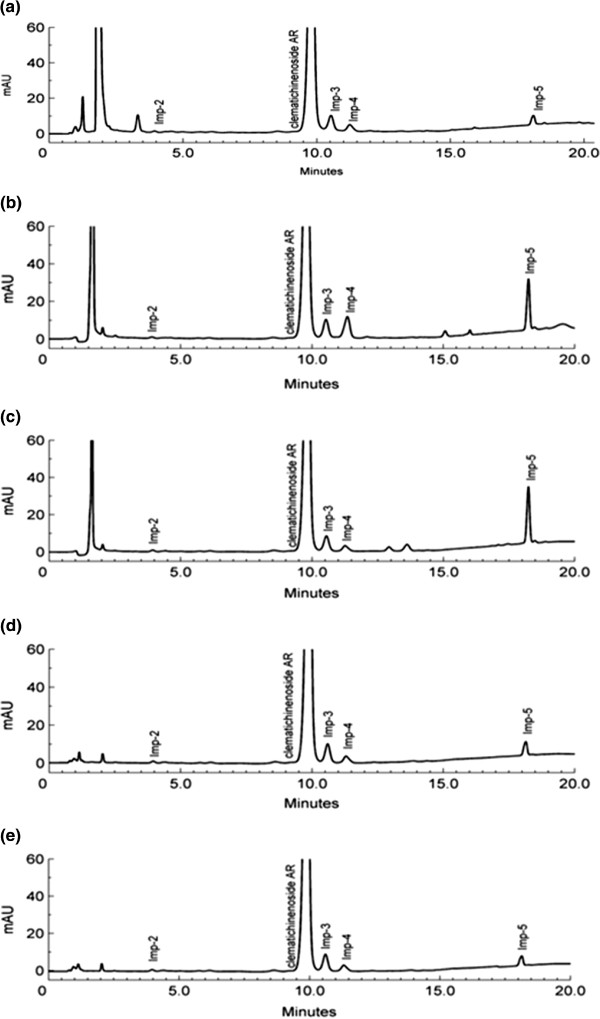
Typical chromatogram of clematichinenoside AR under stress conditions: (a) oxidative degradation, (b) acid hydrolysis, (c) base hydrolysis, (d) thermal degradation, (e) photolytic degradation.